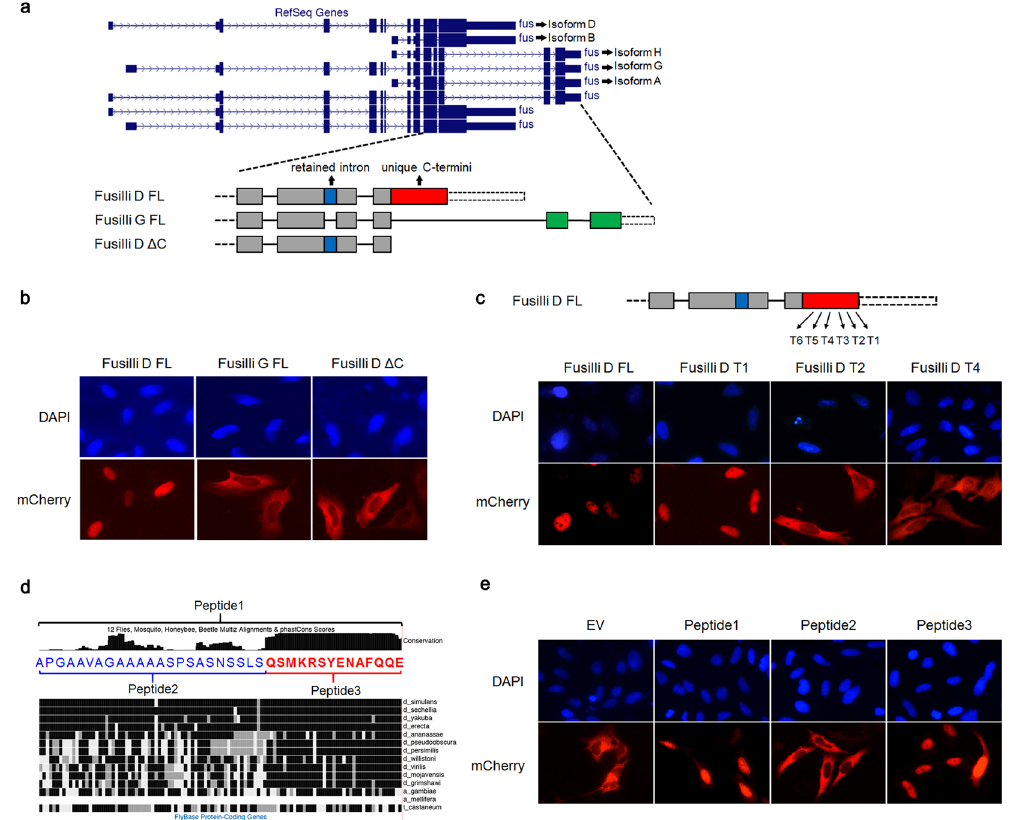
Figure 4. Fusilli expresses both nuclear and cytoplasmic isoforms as a result of alternative splicing. ( a ) A screenshot of the genome browser view with all fusilli isoforms and schematic of isoform D and G. fusilli D Δ C represents the C-terminal truncation of isoform D. Gray boxes indicate constitutive exons. Blue box indicates the retained intron; red and green boxes represent unique C-termini. ( b ) Representative images of HeLa cells (20x) transfected with expression vectors of different fusilli isoforms as mCherry fusion depicted in ( a ), from which we concluded that the C-terminus of isoform D is required for nuclear localization. ( c ) Representative images of HeLa cells (20x) transfected with expression vectors of multiple truncations from the C-terminus of isoform D, from which we concluded that the sequence required for nuclear localization of fusilli resides in the region between T1 and T2. ( d ) Alignment of the 37 amino acid peptide between T1 and T2 (peptide 1) of fusilli from different species revealed a highly conserved fourteen amino acid peptide sequence (peptide 3). ( e ) Representative images of HeLa cells (20x) transfected with different reporter vectors confirmed that peptide 3 is sufficient for nuclear